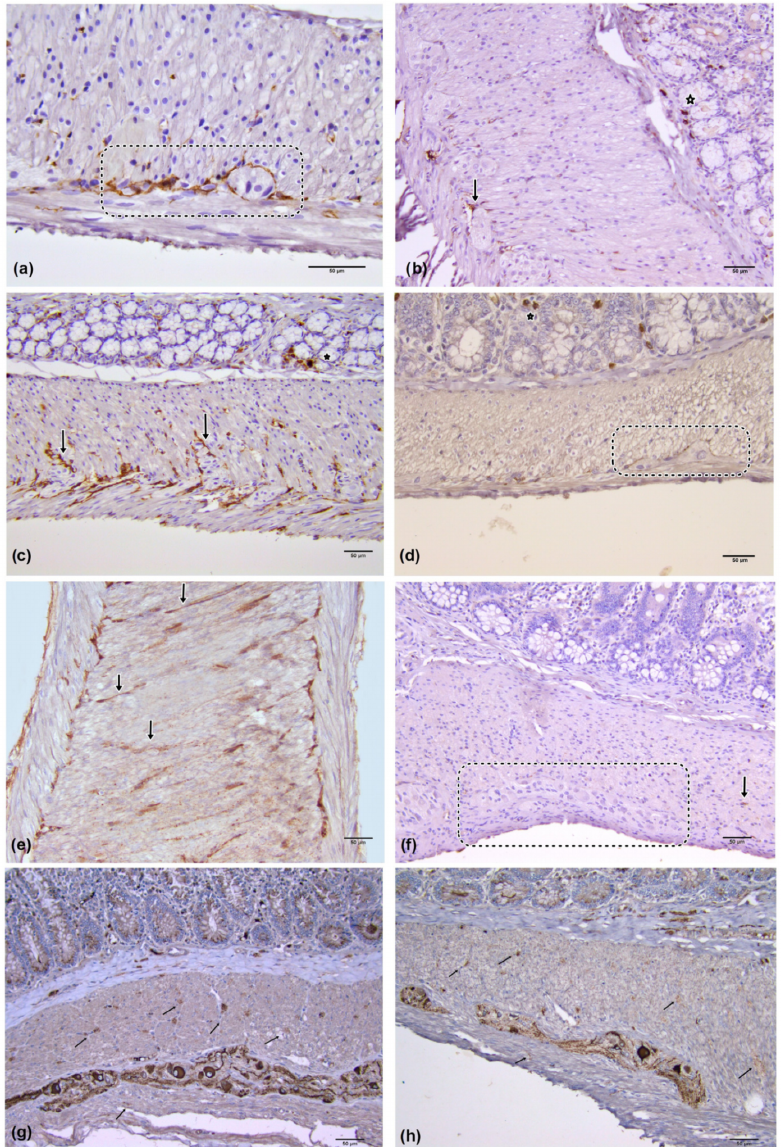
Figure 2. c-kit ( a – f ) and NF-M ( g , h ) immunohistochemistry. ( a ) longitudinal section of the proximal colon of control group; ICC-MP were densely distributed at the boarder of the circular and longi- tudinal muscle sublayer and around the MP ganglion (dashed line) × 400; ( b ) longitudinal section of the proximal colon of the group with diabetes mellitus, rare ICC-IM, single ICC-MP cell (arrow) present around the ganglion and c-kit immunoreactive mast cells in the mucosa (asterisk) × 200; ( c ) longitudinal section of the circular muscle layer of control group distal colon, ICC-IM (arrow) were numerous, c-kit immunoreactive mast cells in the mucosa (asterisk) × 200; ( d ) longitudinal section of the distal colon of the group with diabetes mellitus, partial surrounding of MP ganglion by cytoplasmic processes of ICC-MP (dashed line), c-kit immunoreactive mast cells in the mucosa (asterisk) × 200 ( e ) longitudinal section of the caecum of control group; most commonly c-kit IR ICC-IM were single, but also merged into long linear arrays (arrow) × 200; ( f ) longitudinal section of the caecum of the diabetic group, single ICC-IM in the circular muscle layer (arrow), ganglion MP and almost complete absence of ICC-MP with its cytoplasmic processes (dashed line); × 200 ( g ) NF-M IR MP ganglia and nerve fibers (arrow) in control group proximal colon × 200; ( h ) nerve fibers (arrow) and ganglia of the myenteric plexus in distal colon of the diabetic group × 200. Numerical values presented in the figure correspond to the mean values of the N A of IPC and N A of ICC-IM, * statistical significance ( p ≤